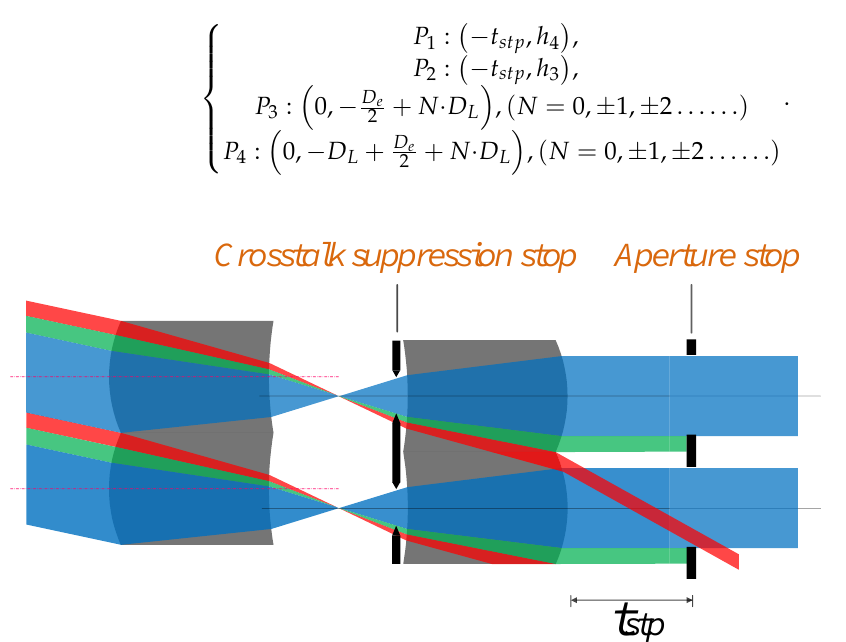
Figure 9. Schematic of the stop placement of an array system.